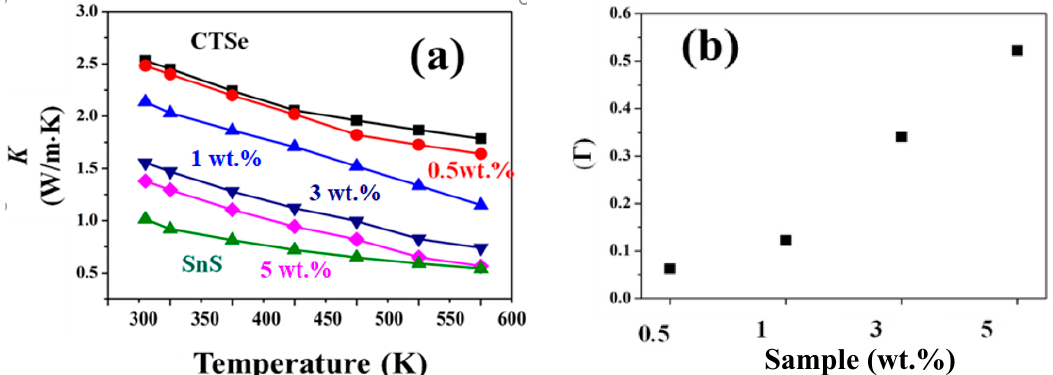
Figure 7. ( a ) Temperature dependence of thermal conductivity of CTSe, SnS, and CTSe-SnS composites and ( b ) lattice scattering parameter values of the CTSe-SnS composite samples.